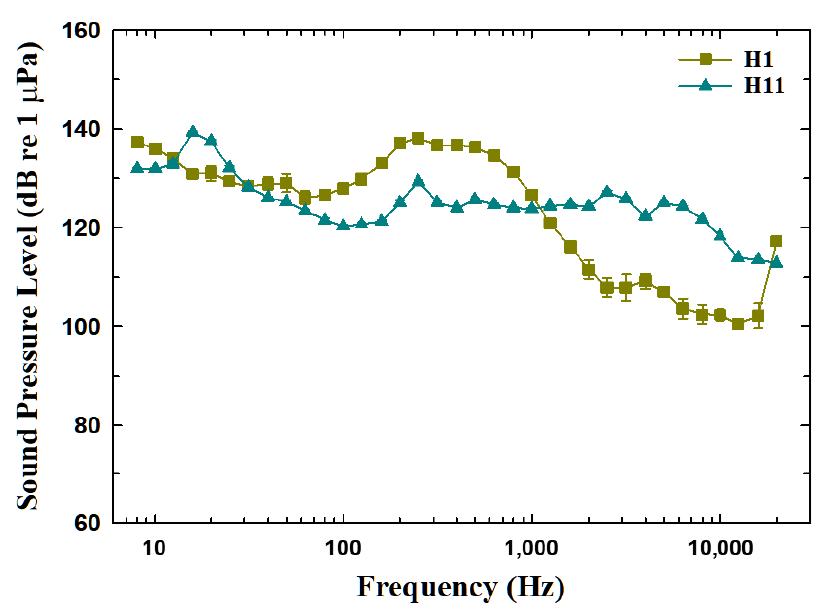
Figure 7. Sound pressure level versus ⅓ octave band frequency in step riffles. The error bars illustrate the standard deviation of the obtained average.